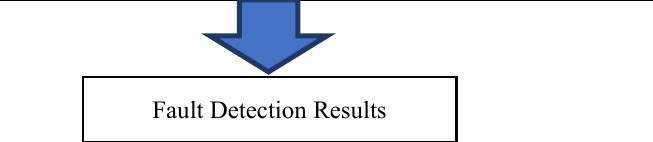
Figure 4. Summary of the suggested technique for finding HVDC faults.